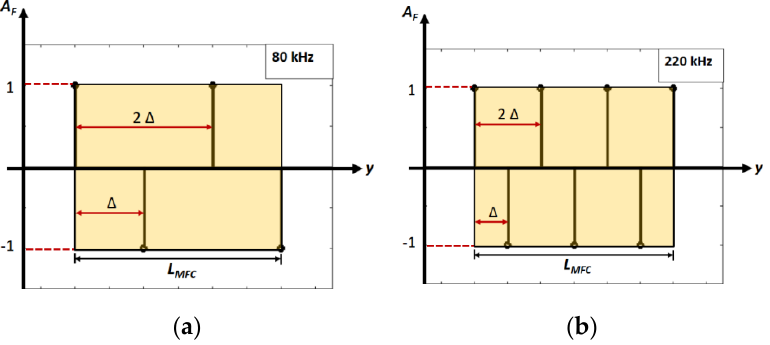
Figure 5. Amplitude correction factor A F at 80 kHz ( a ) and 220 kHz ( b ) along the length of MFC transducer for the A0 mode.